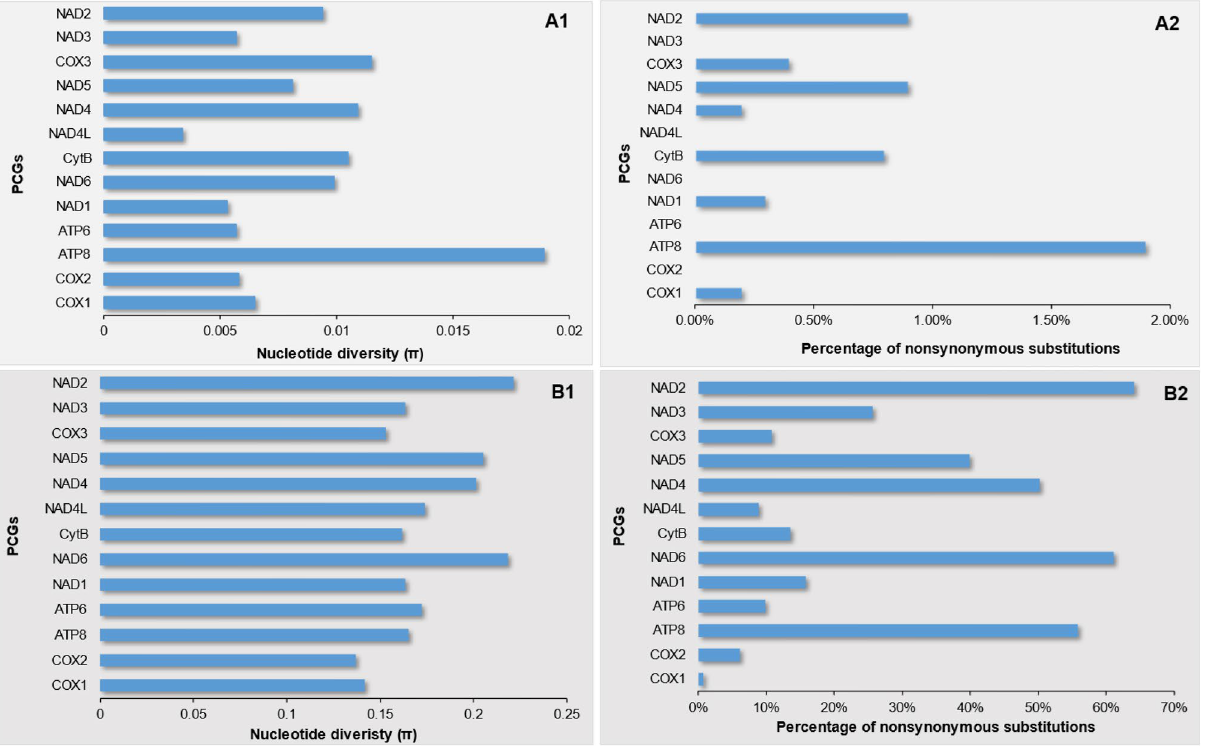
Figure 2. Intra- and interspecific variation in Strombidae. ( A ) intraspecific ( Aliger gigas ), ( B ) interspecific (Strombidae species), (1) nucleotide diversity, (2) proportion in amino acid change per protein coding